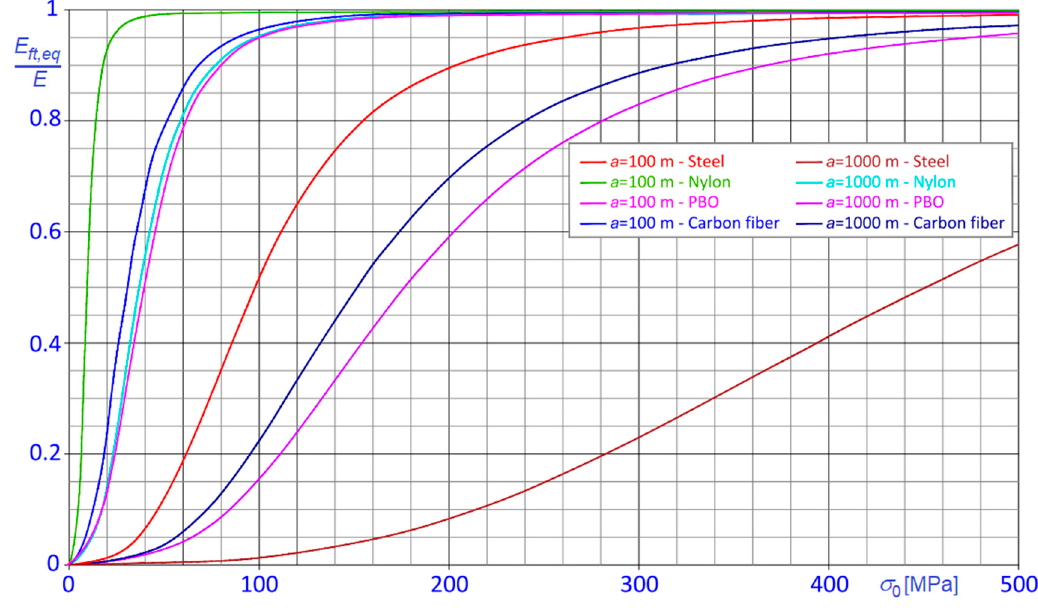
(cid:3006) (cid:3295),(cid:3280)(cid:3292) − σ curves for steel, carbon fiber, PBO and nylon cables: 𝑎 = 100 m ; 𝑎 = 1000 m. Figure 11. E t , eq − 𝜎 (cid:2868) 0 curves for steel, carbon fiber, PBO and nylon cables: a E (cid:3006)